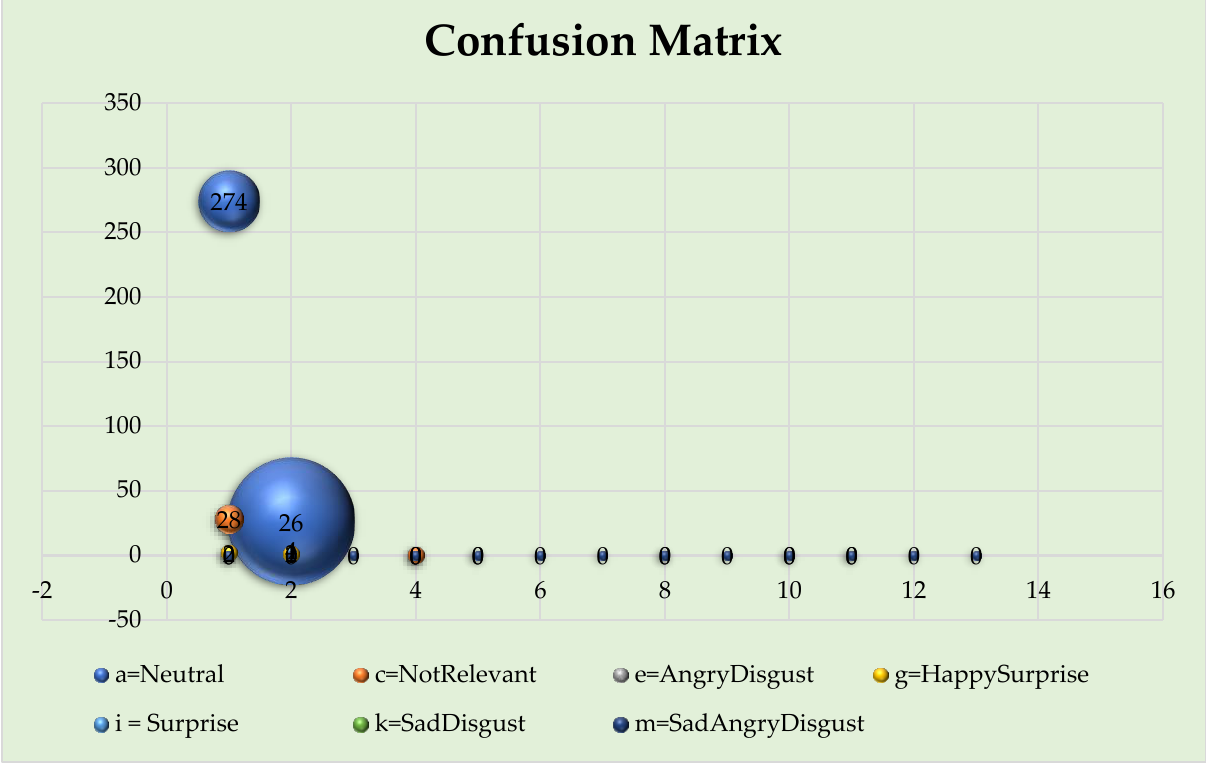
Figure 10. Graphical representation of confusion matrix (tetrad feature selection techniques). Table 10 represents the evaluation accuracy by class using the tetrad of feature selection technique in combination with LL, and its graphical representation is shown in Figure 11. Table 11 presents the cost/benefit assessment summary for the 1085 instances dataset achieved by experiment measurements, and its graphical representation is shown in Figure 12. Table 10. Evaluation summary (tetrad feature selection techniques).